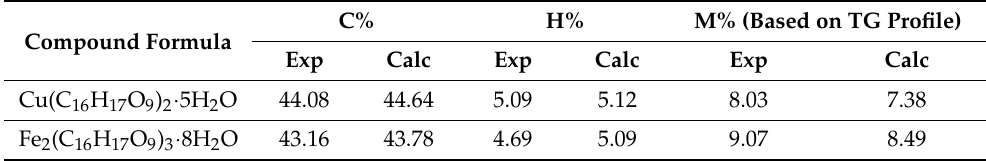
Table 1. Results of thermal decomposition of Cu(II) and Fe(III) 5-CQAs in air atmosphere. Mass Loss/% Anhydrous Residue/% Residue Complex T 1 /°C T 2 / °C T exo Form Found Calc. Found Calc.